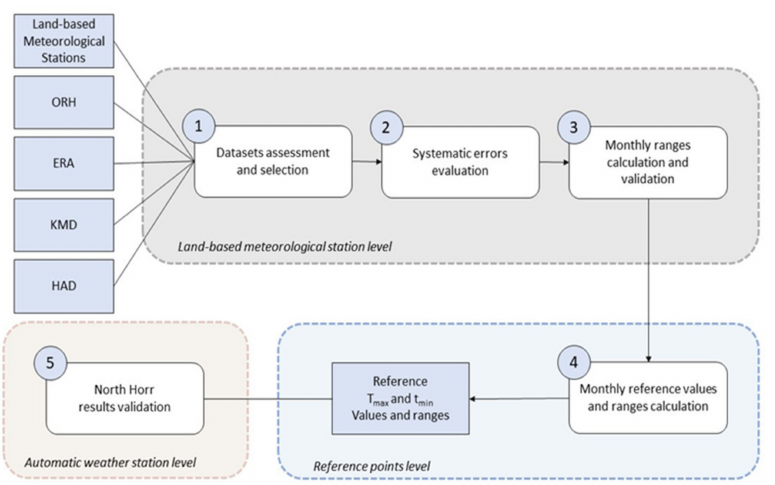
Figure 4. Methodological scheme. ORH, ERA, KMD and HAD refer to the reanalysis datasets used for the comparisons with the observed